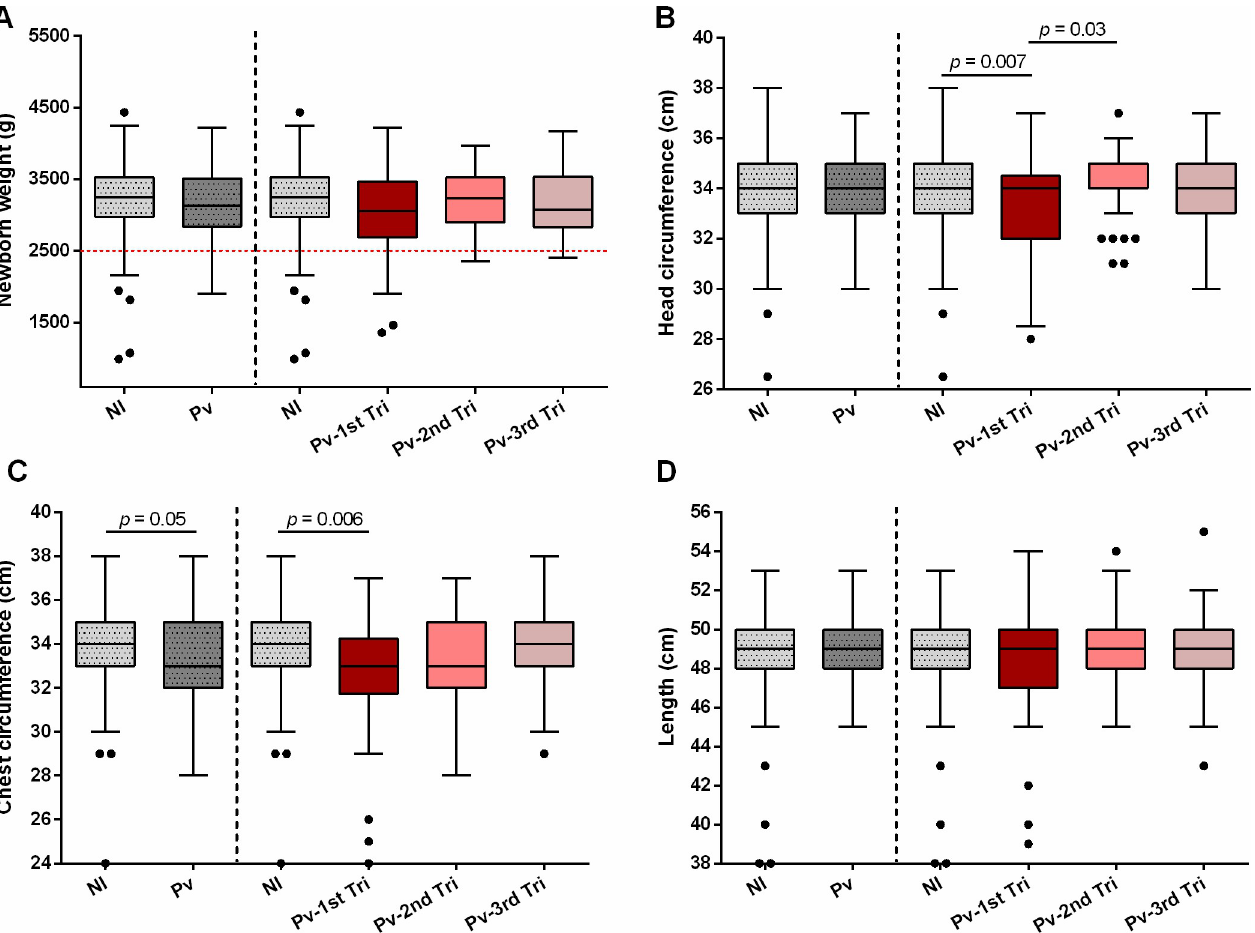
Fig 3. Anthropometric measurements of newborns according to maternal infection and trimester of first infection. (A) Newborn weight; (B) Head circumference; (C) Chest circumference; and, (D) Length. NI–non-infected (N = 160–169); Pv– P . vivax -infected pregnant women (N = 130–150); Pv-1 st tri– P . vivax infection 1 st trimester (N = 38–46); Pv-2 nd tri– P . vivax infection 2 nd trimester (N = 43–54); Pv-3 rd tri– P . vivax infection 3 rd trimester (N = 49–50). Weight is given in grams (g). Head and chest circumferences, and body length are informed in centimeters (cm). Data are represented as Tukey boxplots, with the bottom and top of each box representing the first and third quartiles; the line inside the box is the median, and the whiskers represent the lowest and the highest data within 1.5 IQR of the first and upper quartiles; and the circles, outliers. Differences between groups were determined by multiple liner regression (adjusted for maternal age, gravidity status, residence, education level, and